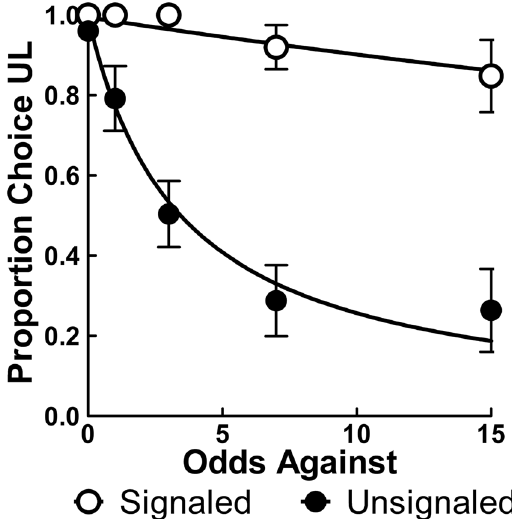
Figure 3. Mean ( ± SEM) proportion choice of the UL alternative averaged over the last five sessions of training following the reversal ( n = 10). Slope parameter estimates ( h ) from Equation 1 were 0.29 for the Unsignaled group and 0.01 for the Signaled group.